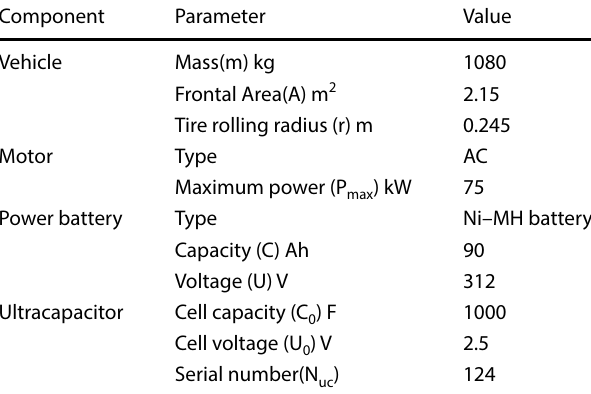
Table 6 Basic parameters of the hybrid electric vehicle